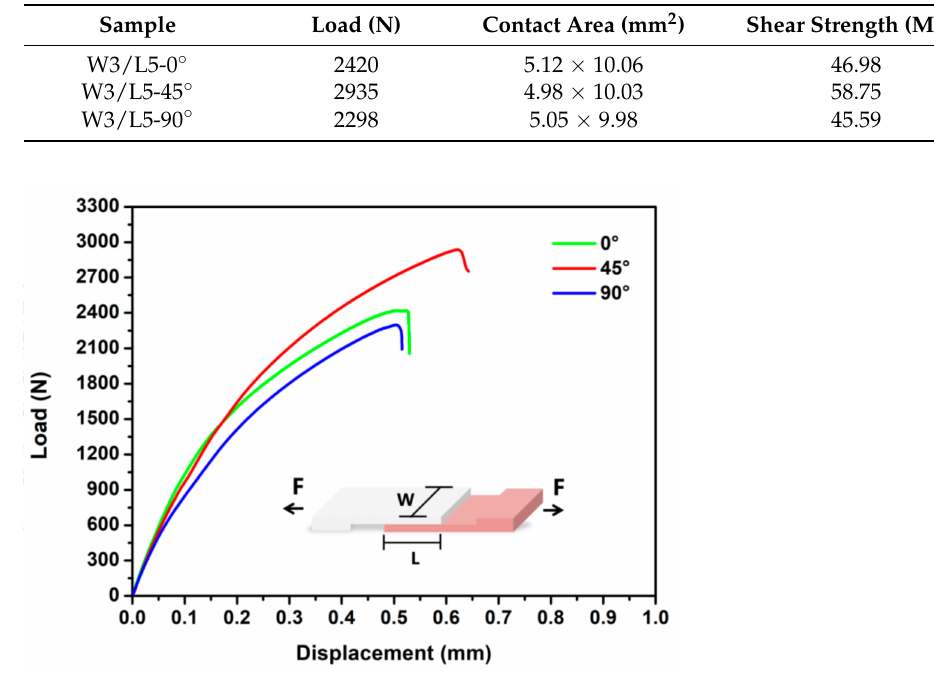
Figure 8. Load-displacement curves of W3/L5 laminated composite applied to shear force along 0 ◦ , 45 ◦ and 90 ◦